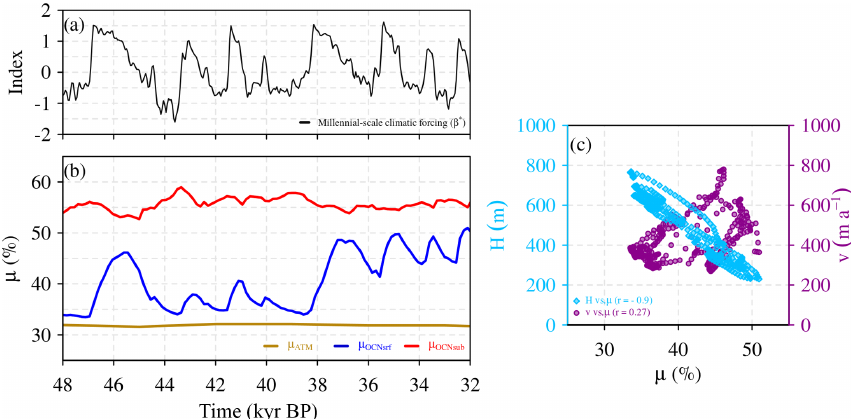
Figure 11. Dynamic behavior of the EIS during millennial-scale climatic transitions for the OCN srf , OCN sub and ATM experiments. Dis- placement of the grounding line in the Bjørnøyrenna Basin (b) in response to the climatic β (cid:63) forcing (a) . The evolution of the grounding-line position is shown for OCN srf (blue), OCN sub (red) and ATM (gold). The migration of the grounding line has been characterized as an index µ ( t ) that represents the evolution of the number of points of grounded ice N g ( t ) over a fixed area of N points in the Barents Sea region, defined over the black square highlighting the Bjørnøyrenna Basin shown in Fig. 2. Increasing values of µ indicate grounding-line retreat. (b) OCN srf scatterplot diagram showing the relationship between mean ice thickness H in the region of the Bjørnøyrenna Basin and µ (light blue diamonds) as well as the relationship between ice-stream velocities v in the same region and µ (purple circles).